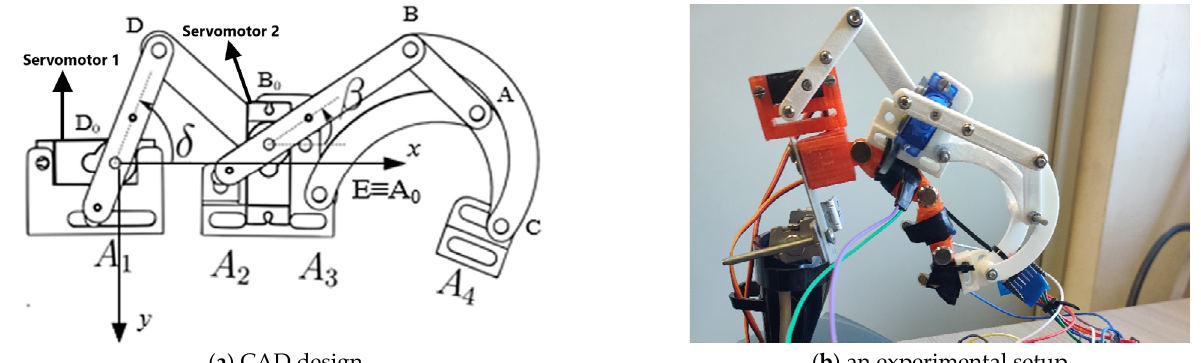
Figure 1. Kinematic design of the proposed ExoFinger exoskeleton, [28].